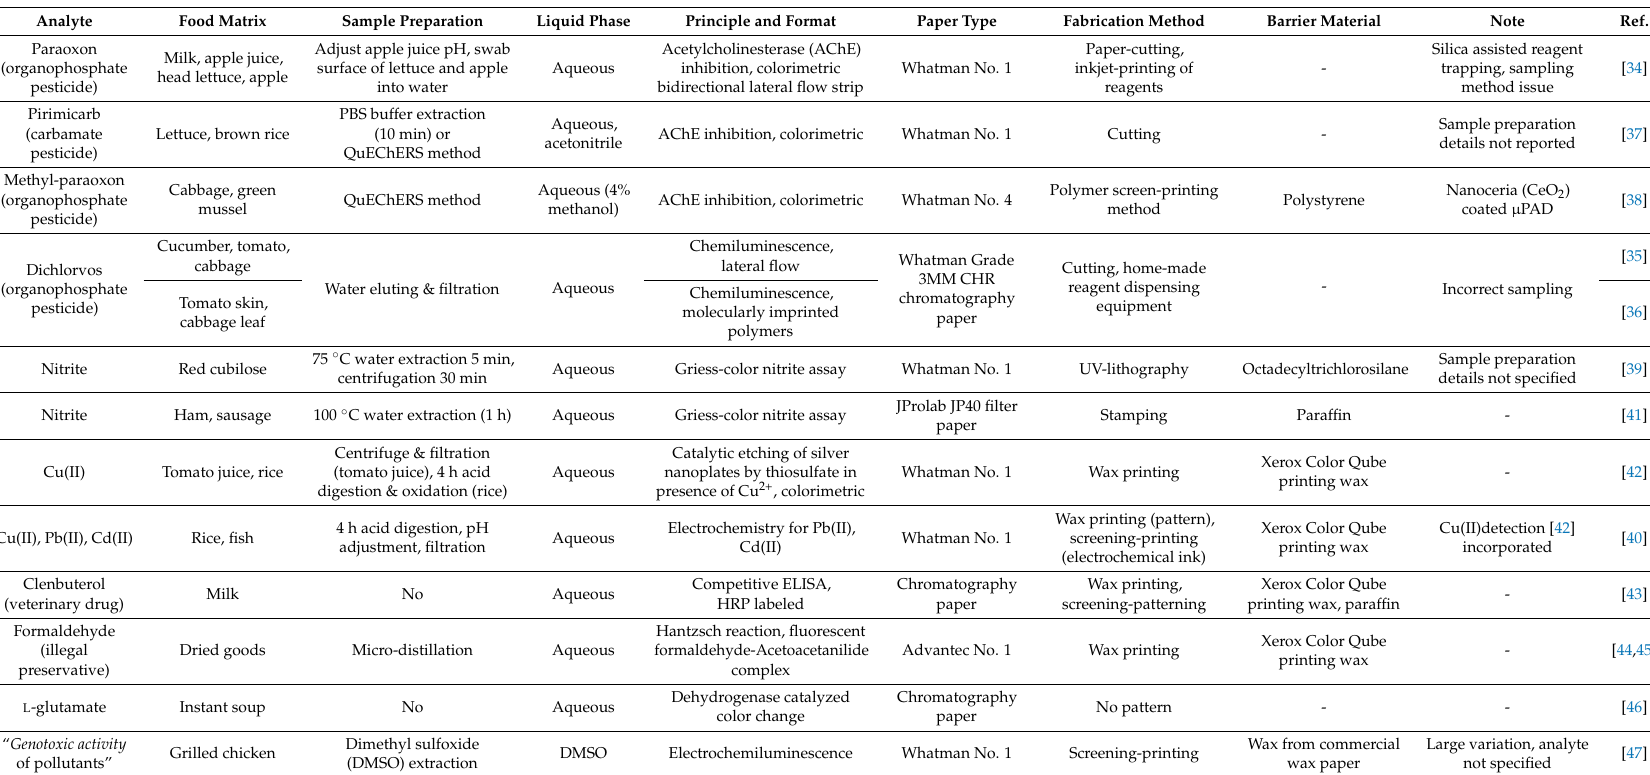
Table 2. Summary of microfluidic paper-based analytical device ( µ PAD) applications in detecting chemical hazards in food